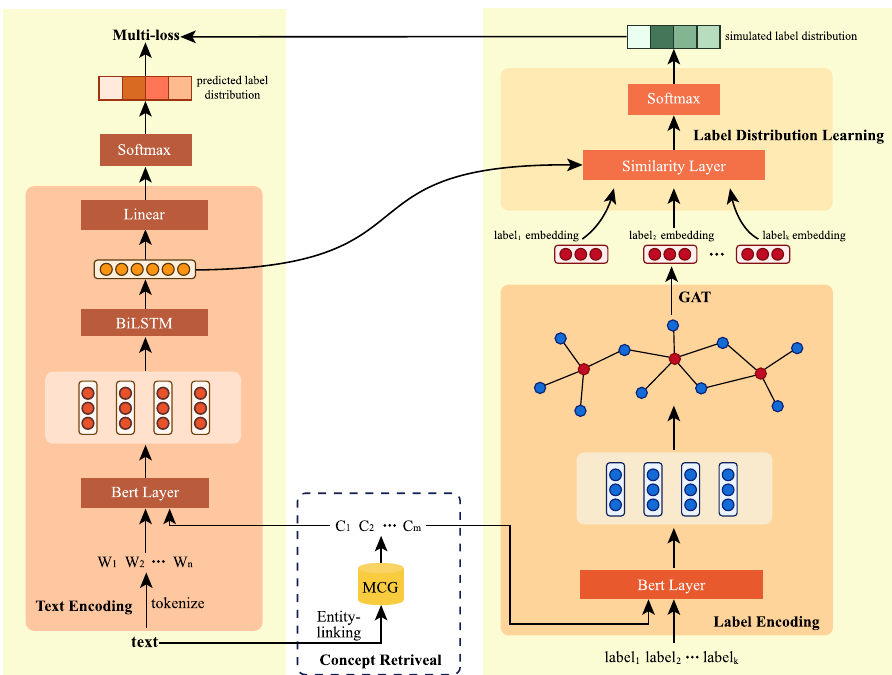
Fig. 2 The structure of the SLDC model. MCG means the Microsoft Concept